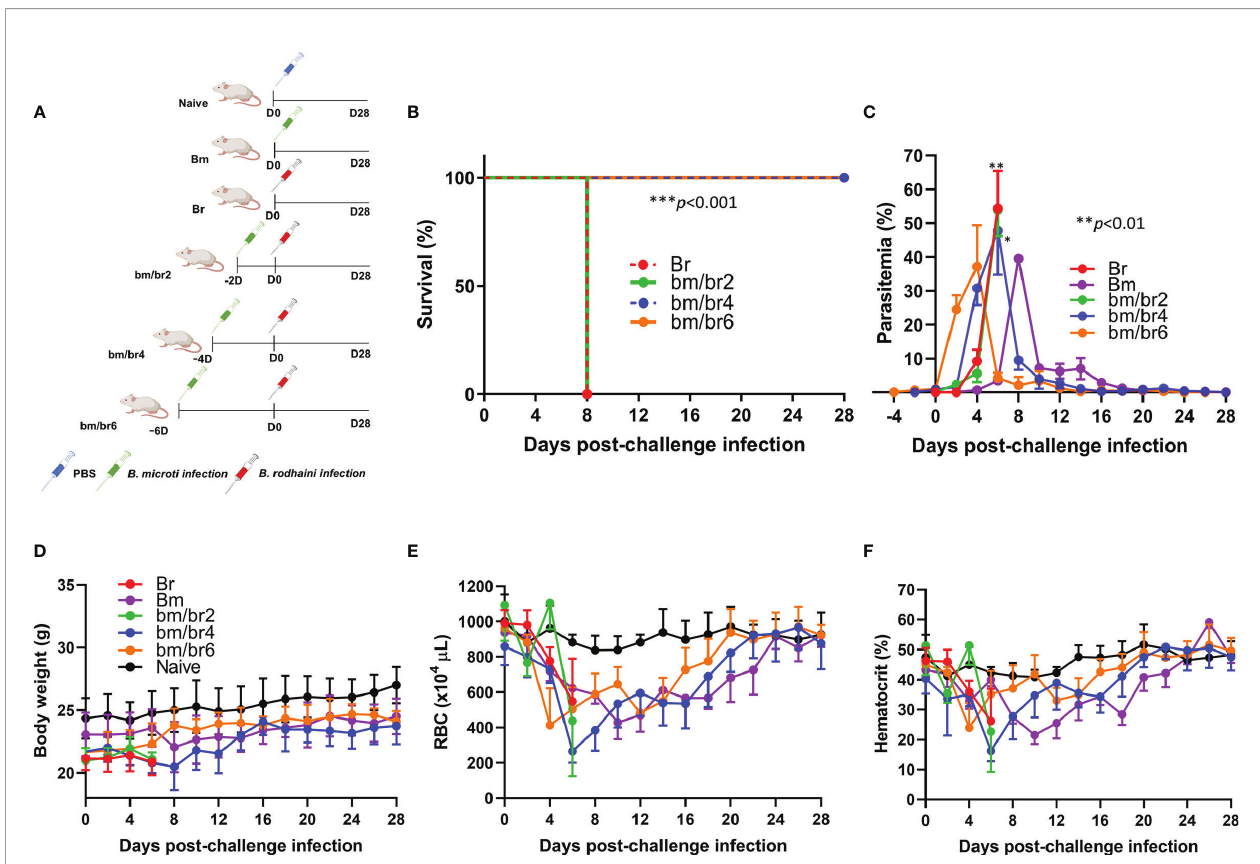
FIGURE 1 | The course of B. rodhaini challenge infection in BALB/c mice undergoing acute B. microti infection. Test BALB/c mice were initially infected with B. microti and then challenge infected with B. rodhaini at different time points (on days 2, 4, 6) post-primary infection. (A) Overall experimental plan. (B) Survival curve, (C) course of parasitemia, (D) body weight, (E) red blood cell (RBC) count, and (F) hematocrit values were monitored for 28 days after challenge infection. Mean percent parasitemia, body weight, RBC, and hematocrit values were calculated from individual values taken from all surviving mice at each speci fi c time point. Results are expressed as the mean values ± standard deviation (SD) of six mice (n = 6). Ordinary one-way analysis of variance (ANOVA) with Tukey ’ s test was used for the comparison of parasitemia between Br and co-infected groups, while the Kaplan-Meier non-parametric model was used for the survival analysis. Asterisks indicate statistical signi fi cance (* p < 0.05; ** p < 0.01; *** p <